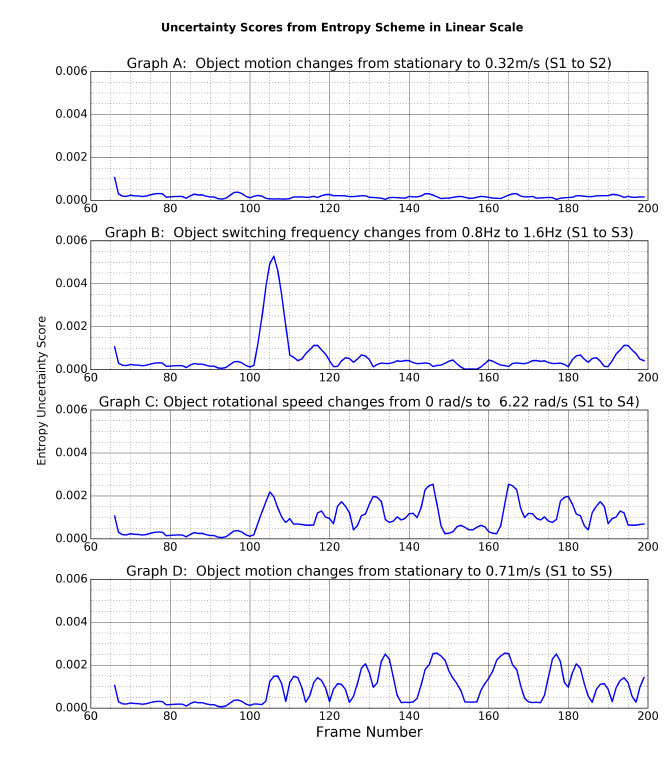
Figure 8. Uncertainty scores from entropy scheme in linear scale.